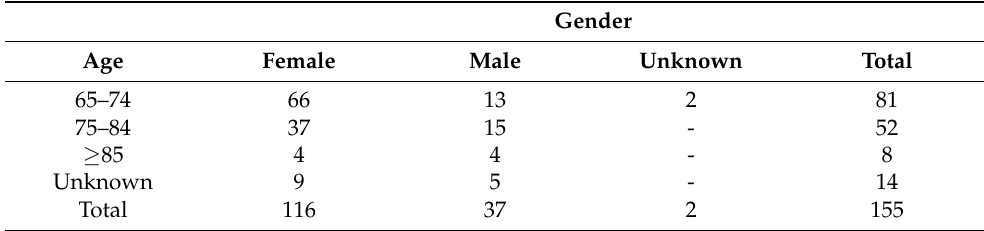
Table 1. Characterization of the sample by gender and age.